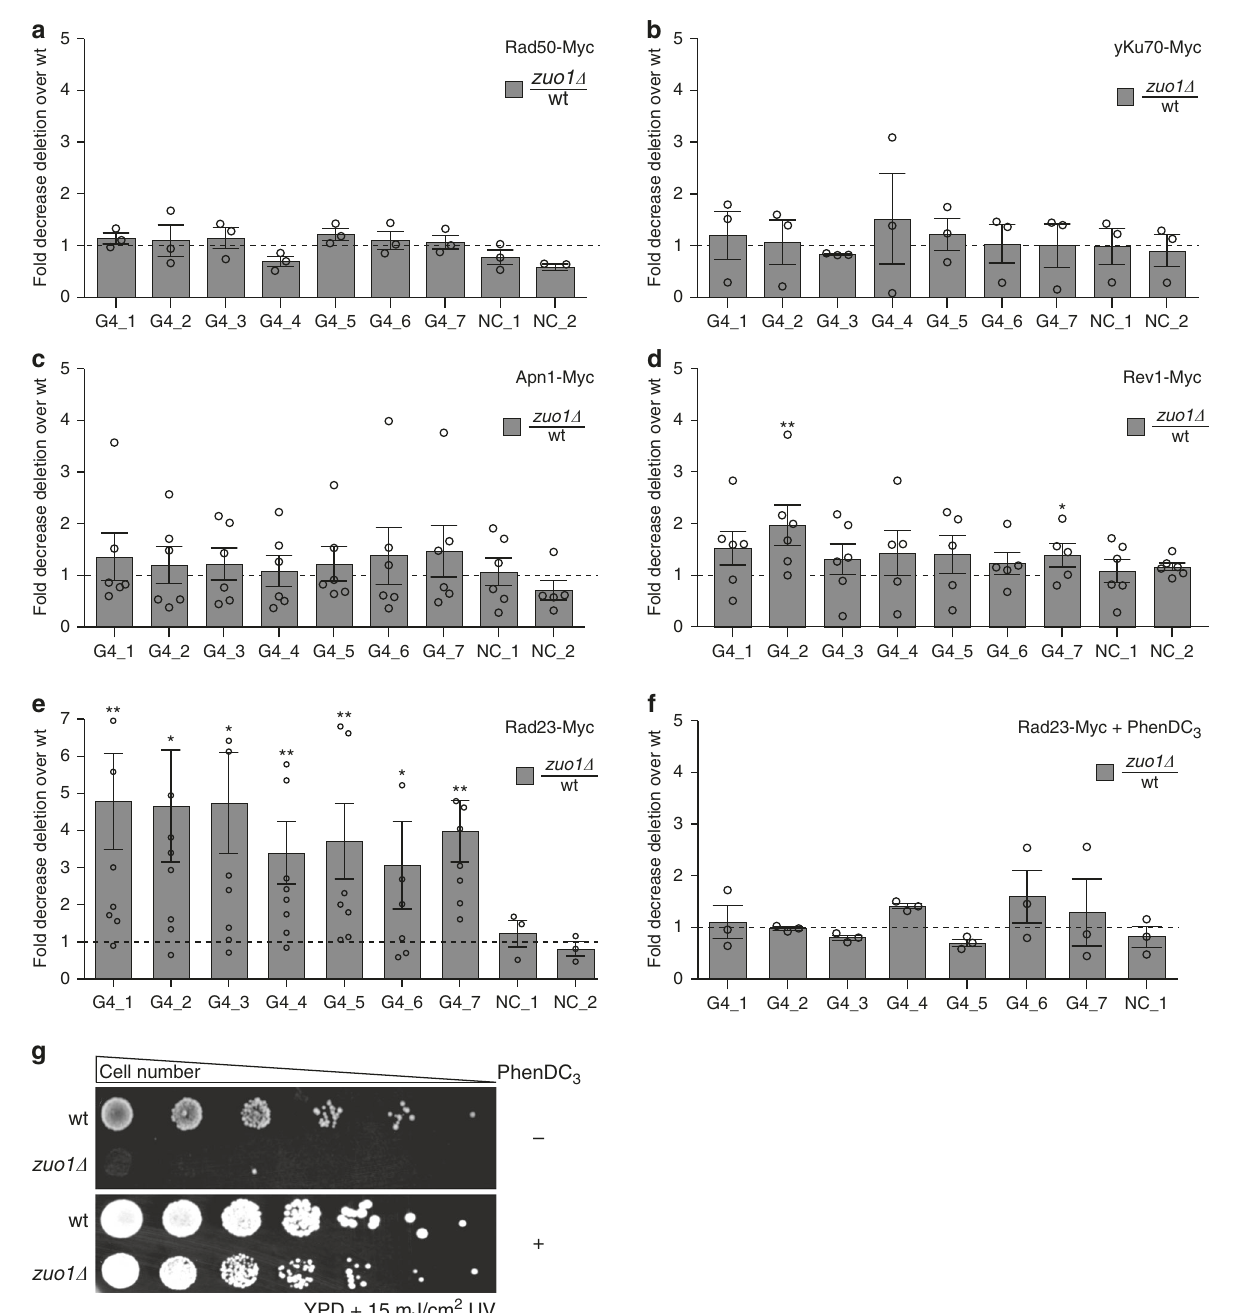
Fig. 4 Zuo1 mediates NER pathway recognition at G4 sites. ChIP and qPCR analysis of different repair proteins in wildtype and zuo1 Δ cells. All qPCRs were performed at seven Zuo1 targets (G4_1 – 7) and two controls (NC_1, 2). Presented data show fold decrease zuo1 Δ /wt ± SEM of n = 3 biologically independent experiments. a ChIP and qPCR of Rad50-Myc. b ChIP and qPCR of Ku70-Myc c ChIP and qPCR of Apn1-Myc d ChIP and qPCR of Rev1-Myc e ChIP and qPCR of Rad23-Myc f ChIP and qPCR of Rad23-Myc in the presence of 10 µ M of PhenDC 3 . All plotted results were based on the average of at least three independent experiments ± SEM. Signi fi cance was calculated based on one-sided Student ’ s t -test. Asterisks indicate statistical signi fi cance in comparison with wildtype cells under the same experimental conditions. * p < 0.05, ** p < 0.01. g Yeast cells were grown on liquid media in the presence or absence of PhenDC 3 , irradiated with 15 J m − 2 UV light (254 nm) and spotted in different concentrations of rich media. Growth changes and sensitivity were monitored by colony indicated that Zuo1 supports the binding of Rad23 to G4 motifs. targets and no changes in binding between wildtype and zuo1 Δ To exclude that this effect is speci fi c to Rad23, we monitored the (Fig. 4c, d) indicating that neither BER nor TLS acts at the G4 sites binding pattern of additional NER proteins: Rad4, Rad1 (XPF in targeted by Zuo1. However, Rad23 (a subunit of the Rad4/Rad23 human) and Rad2 (XPG in human) (reviewed in 52 ). Similar to complex; XPC in human) changed its binding pattern to G4 sites in the absence of Zuo1. Zuo1 deletion resulted in at least a three-fold Rad23 also Rad4, Rad1 and Rad2 exhibit signi fi cantly reduced decrease in the binding of Rad23 to G4 sites (Fig. 4e). These results binding to Zuo1 target regions in zuo1 Δ cells (Supplementary